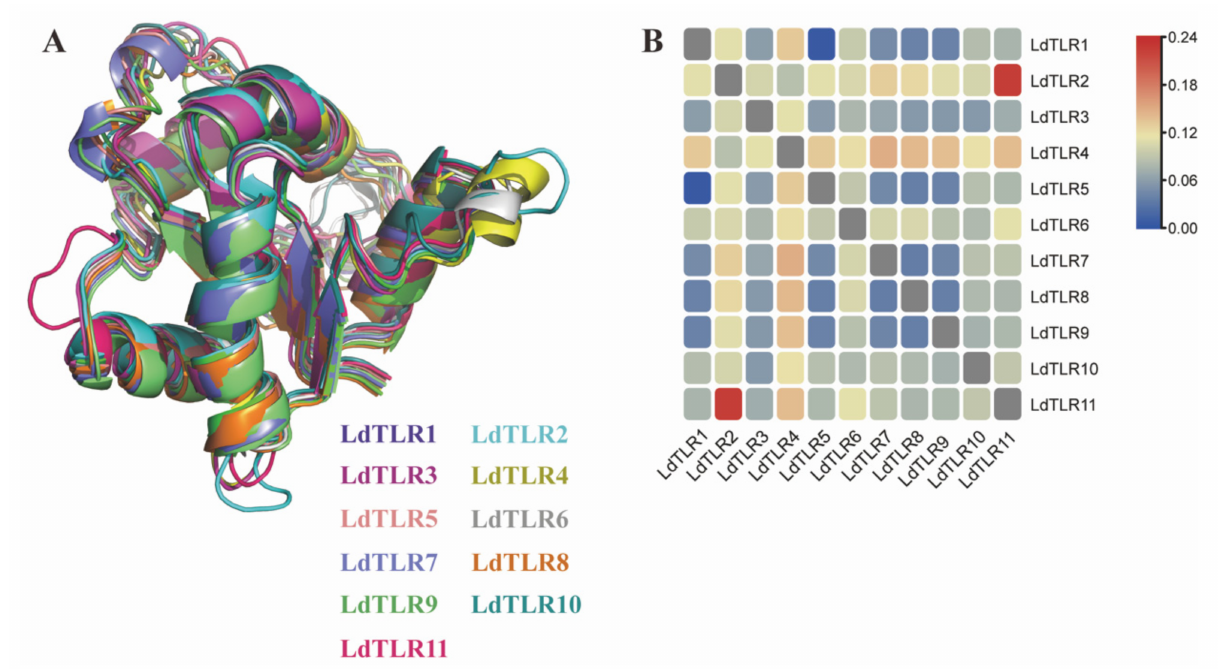
Figure 3. ( A ) Structural alignment of TIR domains of 11 LdTLRs, the colors correspond to different proteins. ( B ) RMSD matrix of TIR domains of 11